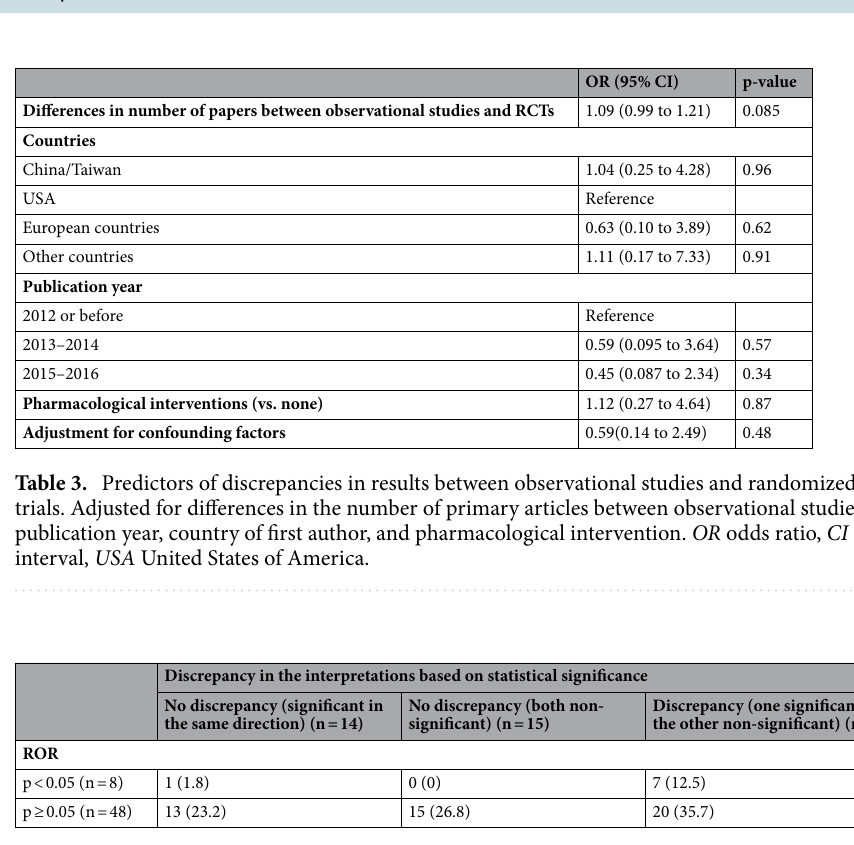
Table 4. Comparison of ROR and discrepancies defined by statistical significance. ROR ratio of odds ratio, number (%).